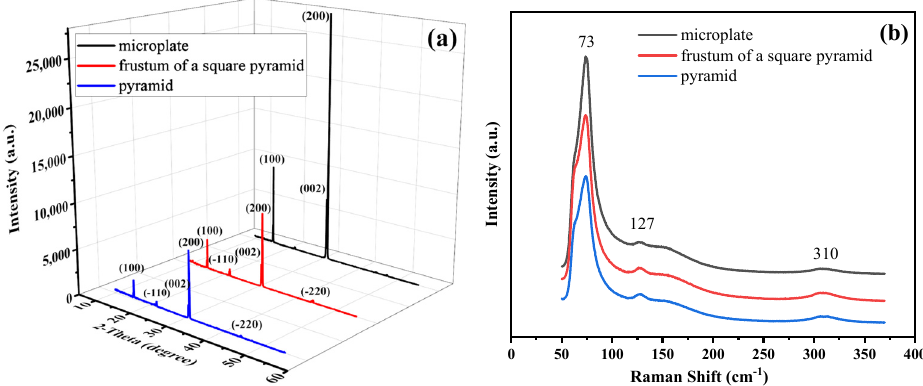
Figure 6. The XRD patterns ( a ) and Raman spectra ( b ) of the samples containing the microplate, frustum of a square pyramid, and pyramid. All the XRD peaks with 2 θ above 10 ◦ can be well indexed to the monoclinic-phase CsPbBr 3 (JCPDS card 18-0364).